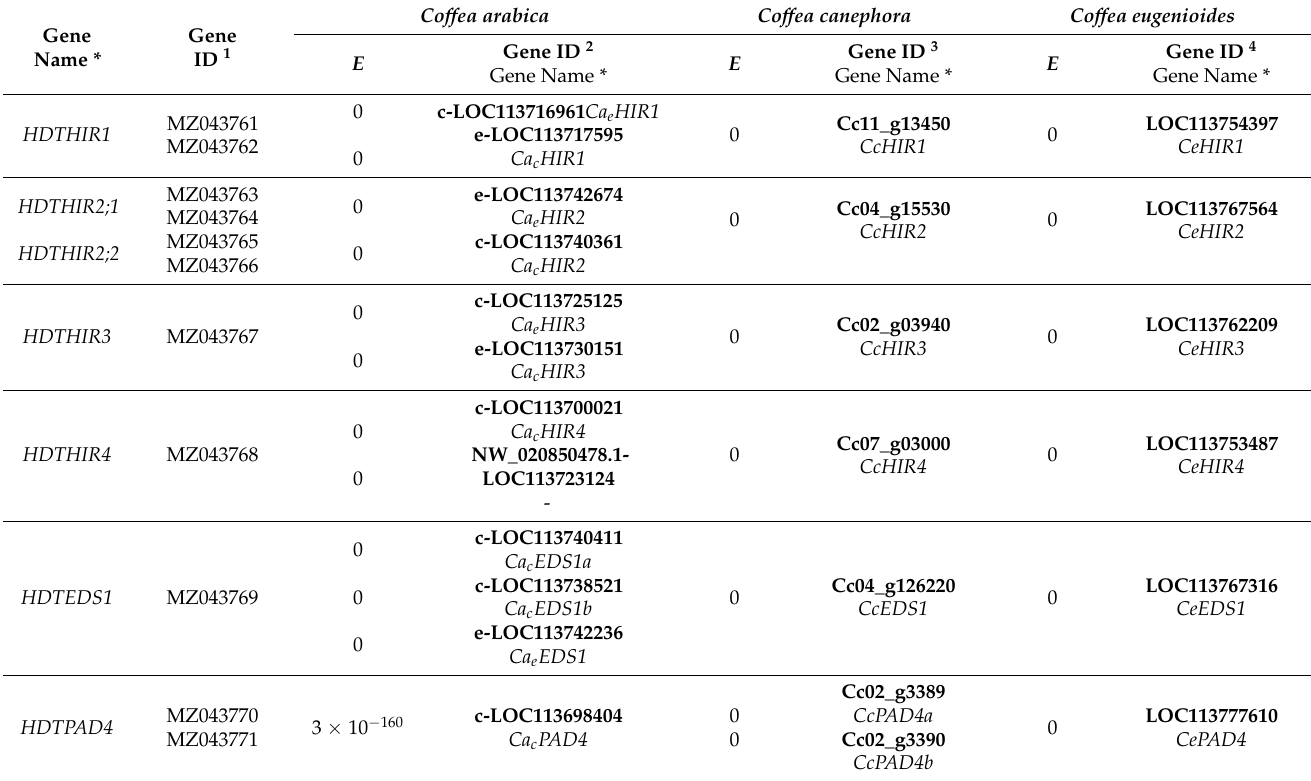
Table 2. HDT transcripts with homology to HIR , EDS1 and PAD4 genes mapped on Coffea arabica , C. canephora and C. eugenioides genomes with the depiction of the e -value ( E